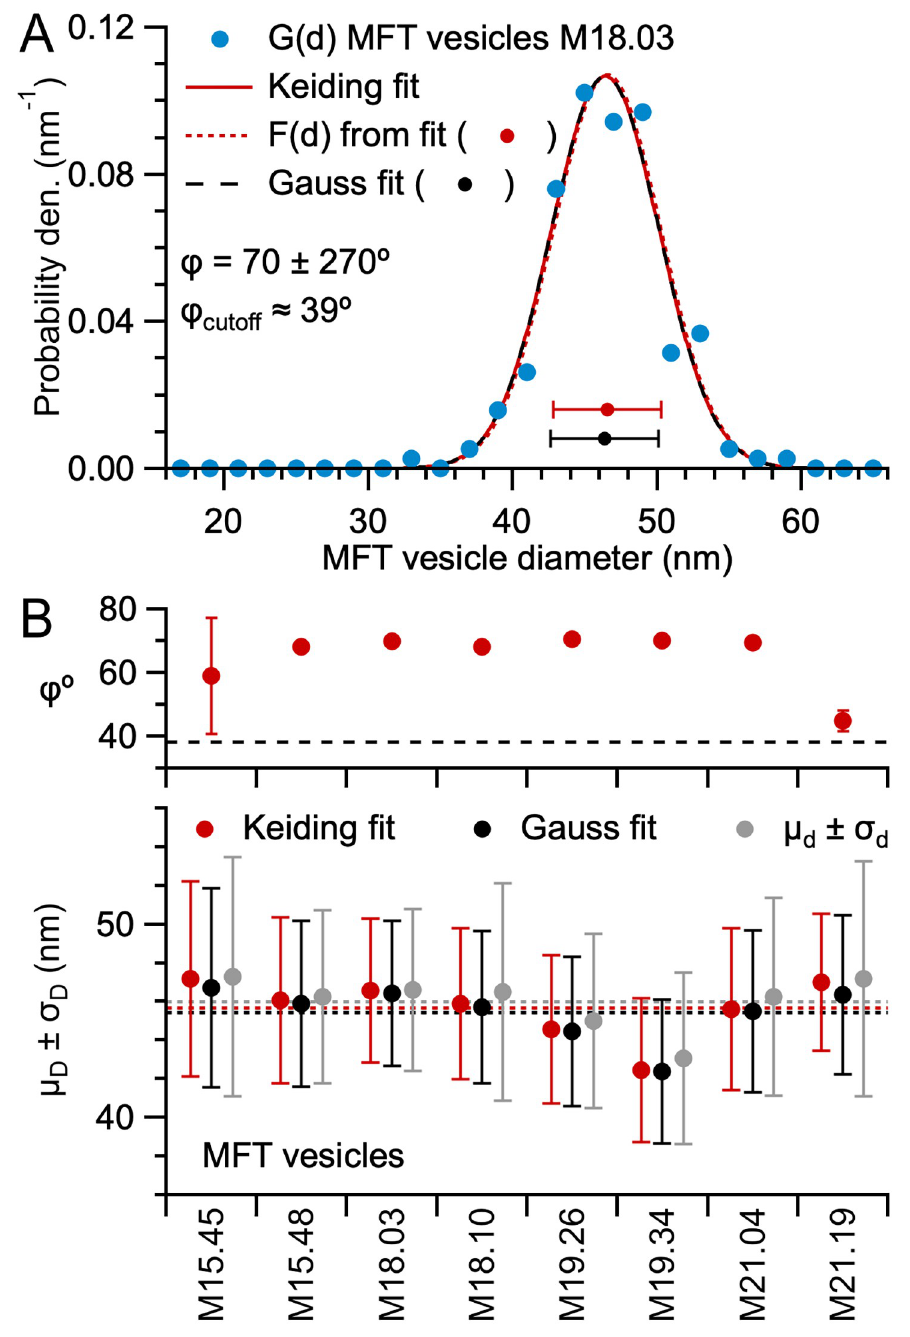
Fig 9. Estimates of F(d) and ϕ from G(d) of MFT vesicles. A. Curve fit of Eq 1 (red solid line) to the G(d) of mouse MFT vesicles in Fig 2C2 (blue circles) resulting in estimates for F(d) (red dotted line and circle), ϕ and ϕ cutoff (Eq 9). A Gaussian fit to the same G(d) (black dashed line) overlaps the Keiding-model fit and μ D ± σ D of both fits overlap (red and black circles) indicating G(d) � F(d). B. Parameters μ D ± σ D (bottom) and ϕ (top) from Keiding-model curve fits to G(d) of MFT vesicles for 4 mice, 2 MFTs per mouse (red circles; S15 Fig in S1 File), compared to μ D ± σ D from Gaussian fits (black circles) and μ d ± σ d computed from 2D diameters. Overlapping distributions again indicate G(d) � F(d). Dotted lines (bottom) denote averages. Black dashed line (top) denotes average estimated ϕ cutoff (~38˚); all estimated ϕ are considered inaccurate. Error bars of ϕ denote fit errors, 6 of which are not shown since they are off scale. See S16 Fig in S1